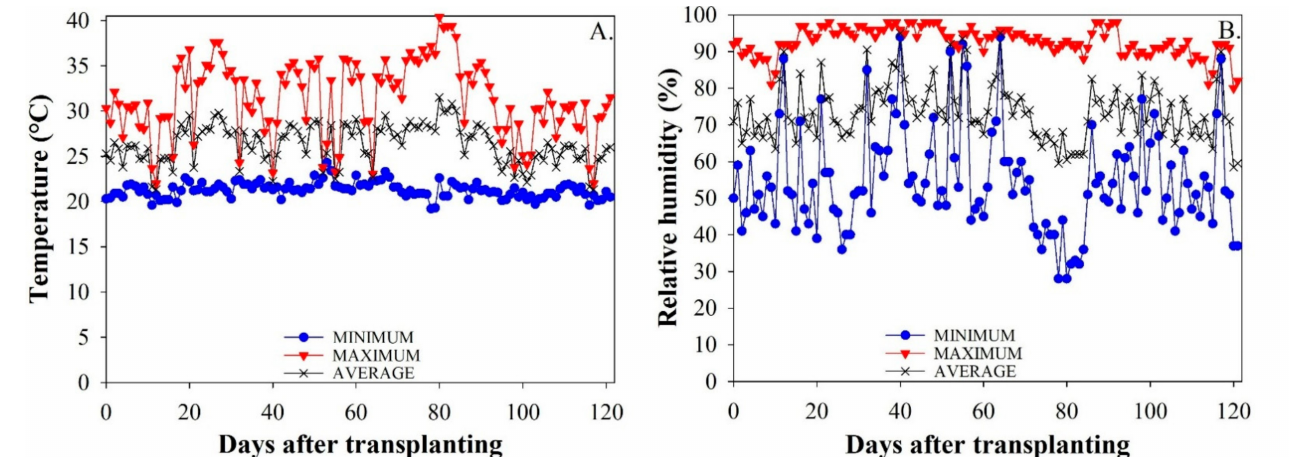
Figure 1. Temperature ( A ) and relative humidity ( B ) inside the greenhouse during the experimental